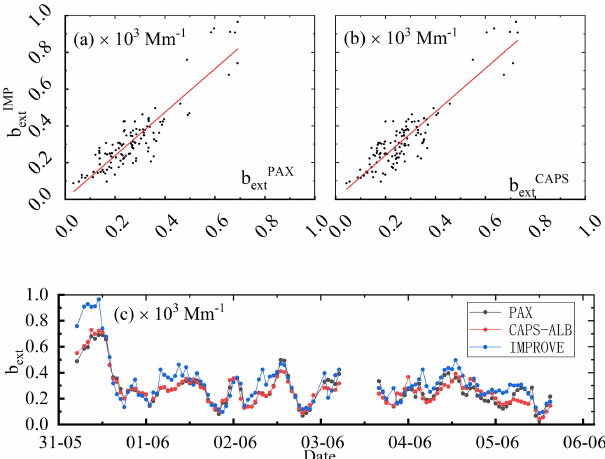
Figure 4. Intercomparison of the measured extinction coefficient of (a) PAX and (b) CAPS-ALB with IMPROVE-calculated extinction coefficient during field measurement (1–6 June 2019), and (c) the timing diagram of the extinction coefficient from PAX, CAPS-ALB measurement and IMPROVE model